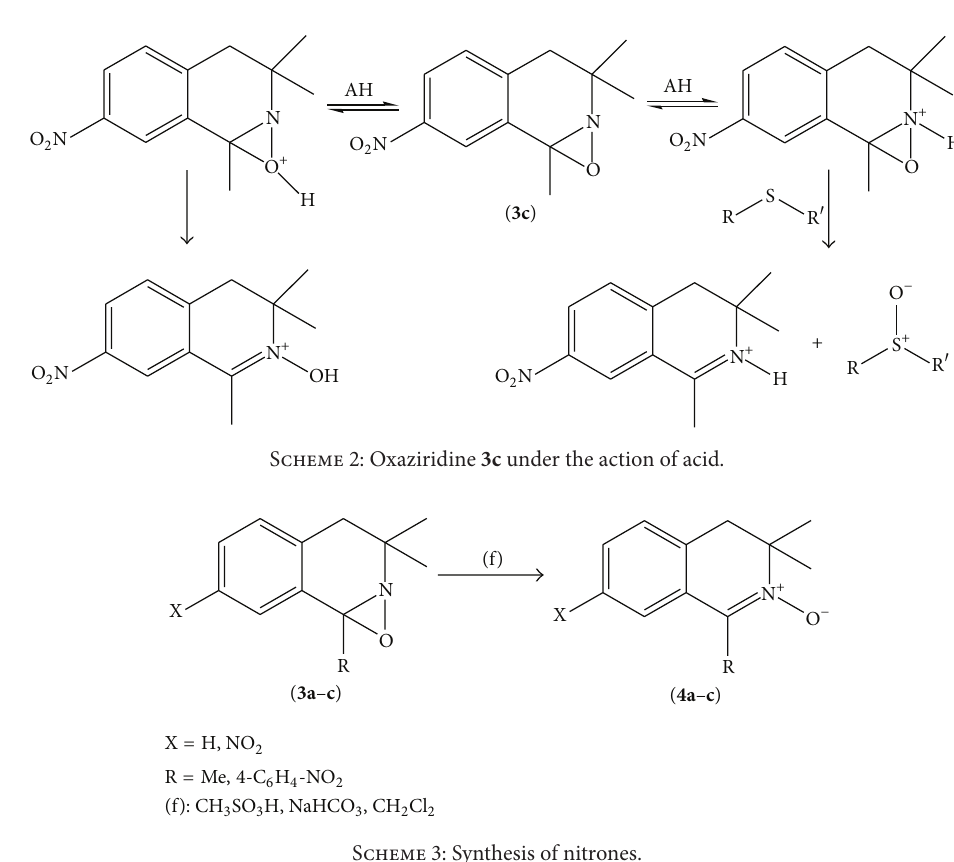
Scheme 1: Reagents and conditions of oxaziridines 3a – c synthesis.